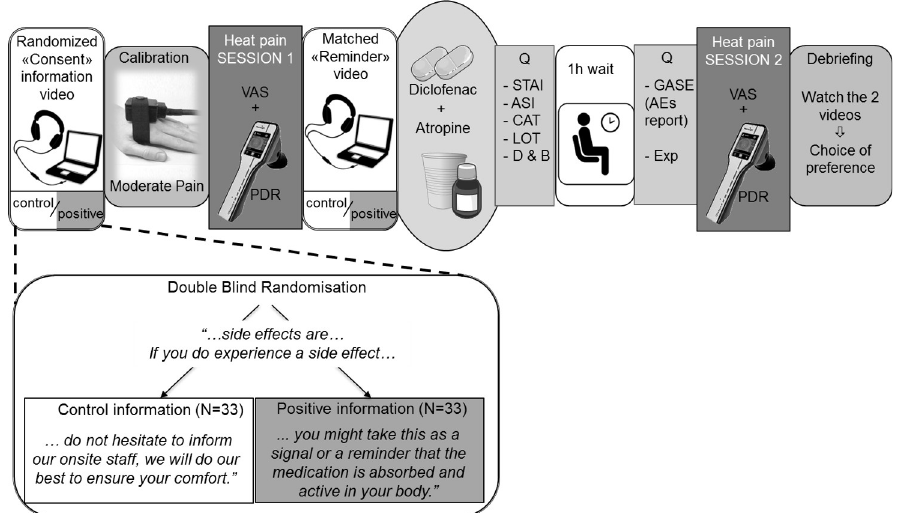
Fig 1. General procedure. Participants were randomized double-blindly to one of the two different information conditions, watching a “consent” information video prior to signing consent. In this video, a physician described the medication’s effects and side effects. The only difference between the two messages concerned side effects and is summarized in the verbatim. After a calibration to determine the temperature eliciting moderate pain, heat pain session 1 took place, with pain intensity Visual Analogue Scales (VAS), and pupillary dilation reflex (PDR) measures. Then, the “reminder” video regarding side effects was watched before taking the study medication. At the beginning and end of the 1-hour long break (while the medication was becoming active), participants filled Questionnaires (Q). A second heat pain testing ensued, and the study concluded with a debriefing. STAI = state-trait anxiety inventory, ASI = anxiety sensitivity Index, CAT = catastrophizing, LOT = life orientation test, D&B = desire and beliefs about medication, GASE = General Assessment of Side Effects, Exp = expectation.